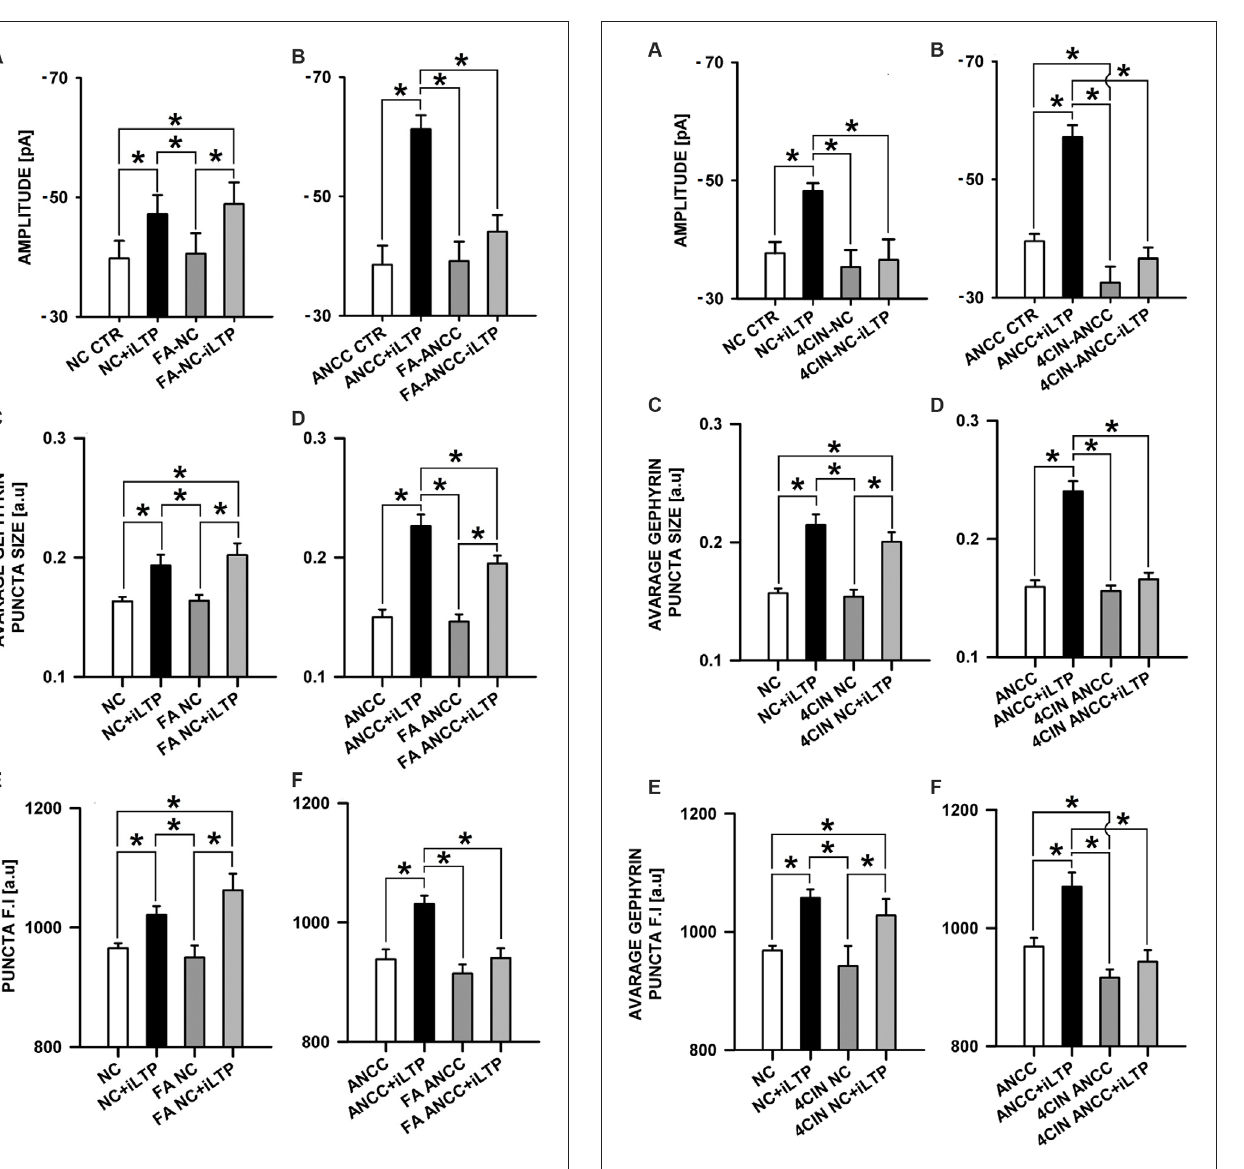
FIGURE 6 | Impact of MCT’s blockade by 4CIN. 4CIN abolishes mIPSC amplitude increase in NC and ANCC but prevents morphological changes only in ANCC. (A) Average mIPSC amplitude in NC, (B) average mIPSC amplitude in ANCC, (C) average gephyrin puncta size in NC, (D) average gephyrin puncta size in ANCC, (E) average gephyrin puncta fluorescence intensity in NC, (F) average gephyrin puncta fluorescence intensity in ANCC. Control group (white bar), NMDA stimulated group (black bar), 4CIN treated group (dark gray), 4CIN treated prior to iLTP induction group (gray bar). Star mark represent statistical significant data ( p <